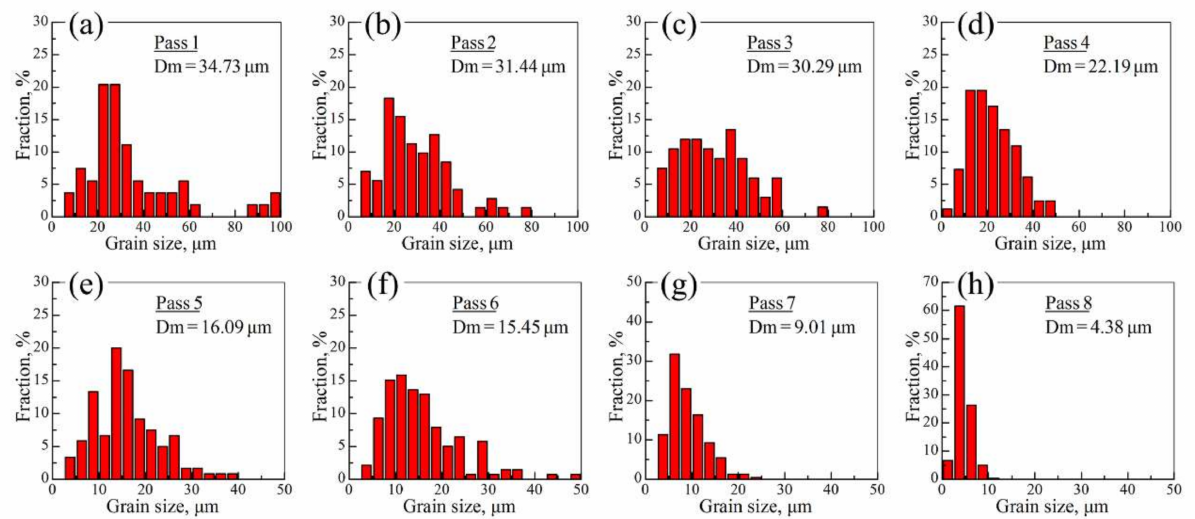
Figure 3. Grain size distributions of AZ31 magnesium alloy sheets during multi-pass lowered- temperature rolling: ( a ) Pass 1; ( b ) Pass 2; ( c ) Pass 3; ( d ) Pass 4; ( e ) Pass 5; ( f ) Pass 6; ( g ) Pass 7; ( h ) Pass 8 (Dm refers to the average grain